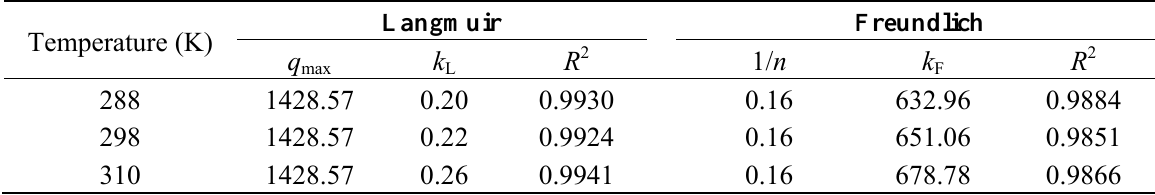
Table 2. Isotherm parameters for the adsorption of doxorubicin hydrochloride (DOX) on graphene oxide (GO).